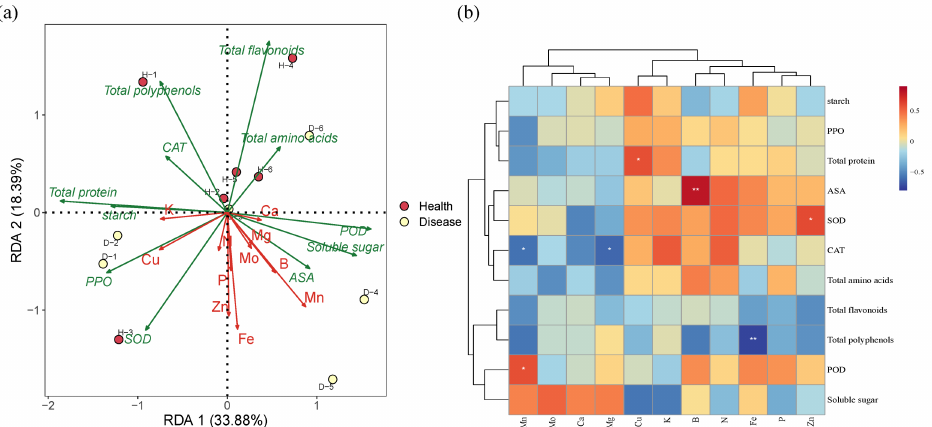
Figure 6. Correlation of nut characteristics with leaf elements. ( a ) Redundancy analysis (RDA). The color ranges of red and green lines ( a ) represented positive and negative correlation, respec- tively; ( b ) Pearson correlation heatmap. * and ** represented the significance at 0.05 and 0.01 levels,